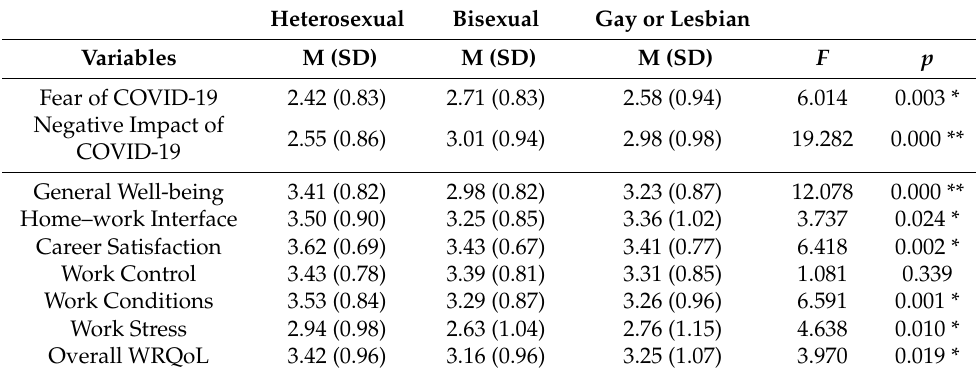
Table 3. Results for all variables by sexual